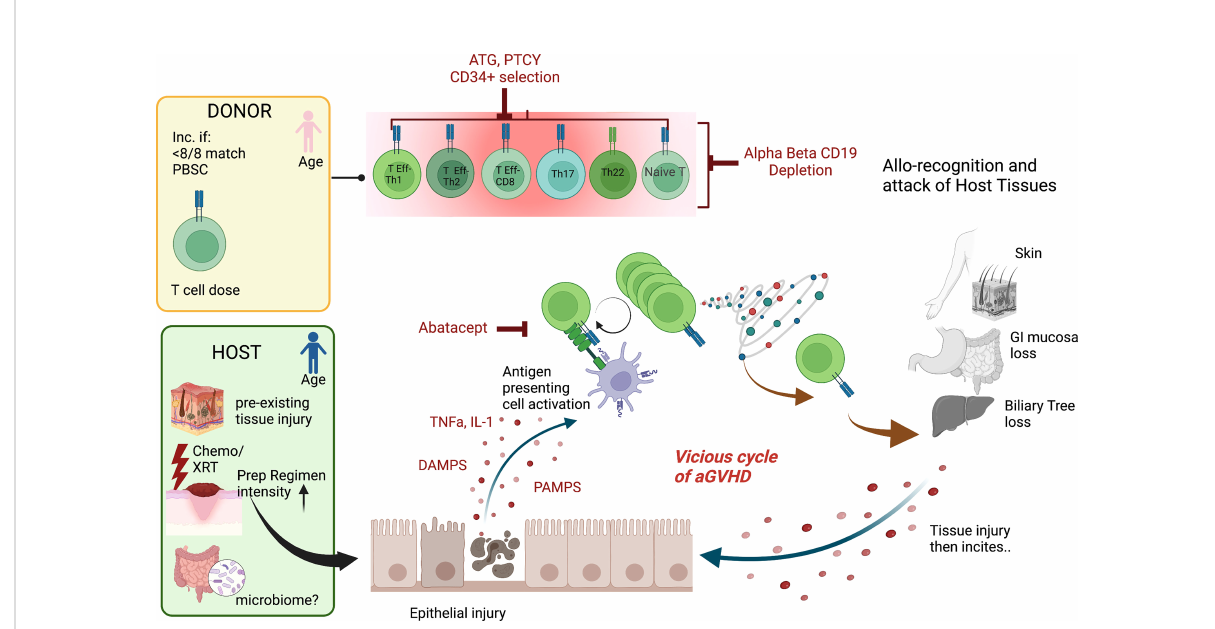
FIGURE 1 Mechanisms of aGVHD Schema of the contributions to acute GVHD after hematopoietic cell transplantation The pink donor and blue recipient represent the gender mismatch (female to male); <8/8 match= not fully HLA matched donor/recipient pair, PBSC, peripheral blood stem cell source; T cell dose, higher T cell doses are linked to more disease. For the host, chemo/XRT, chemotherapy/radiation with increased preparative regimen intensity linked to increased risk of aGVHD and the microbiome potentially playing a role. The key contributing T cell populations are shown (T Eff-Th, T effector helper cell; DAMPS, danger-associated molecular patterns; PAMPS, pathogen-associated molecular patterns. The fi gures were generated by the authors using